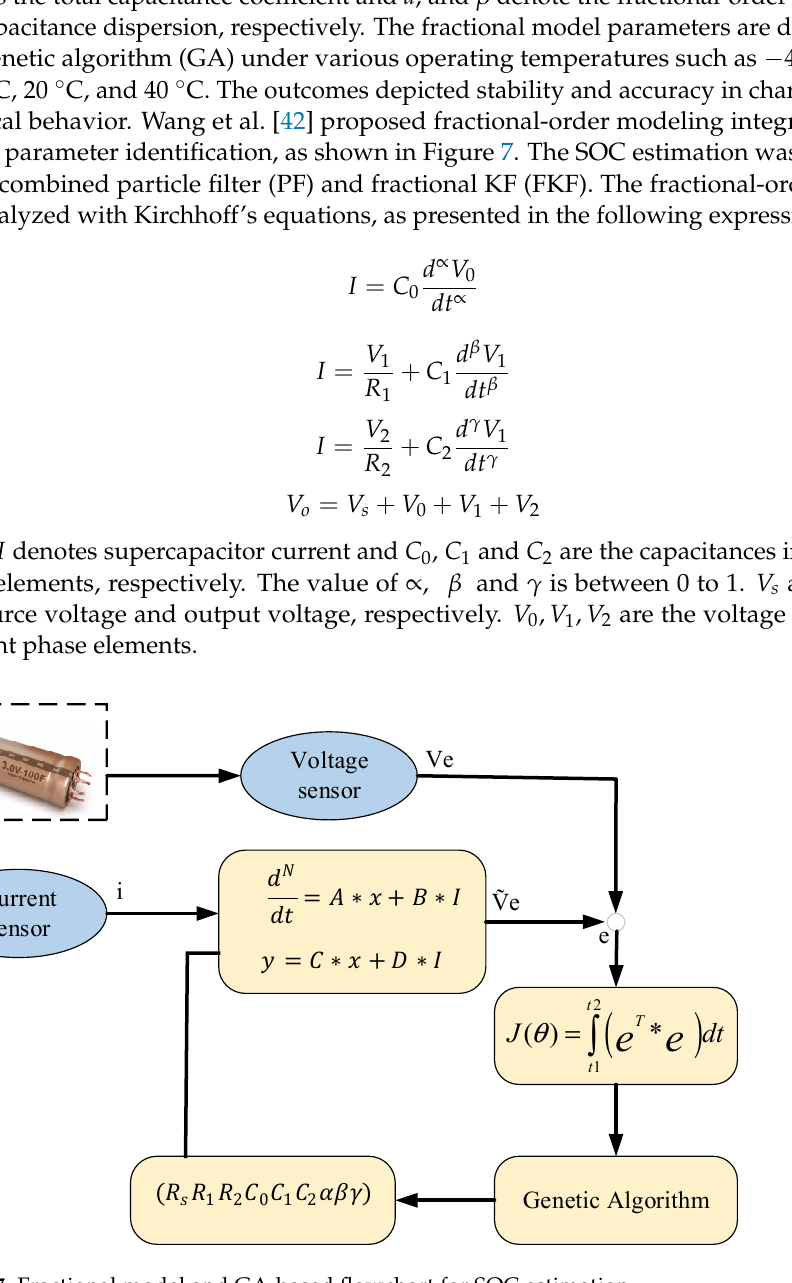
Figure 7. Fractional model and GA-based flowchart for SOC estimation.